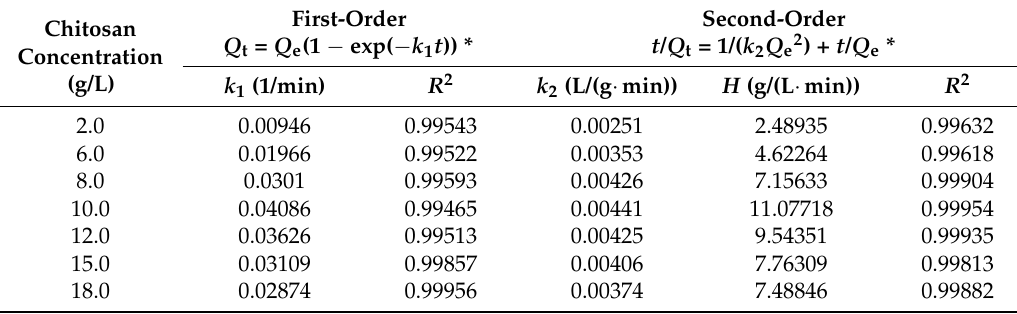
Table 4. Kinetic parameters for the chitosan enzymolysis by pepsin at 50 ˝ C.